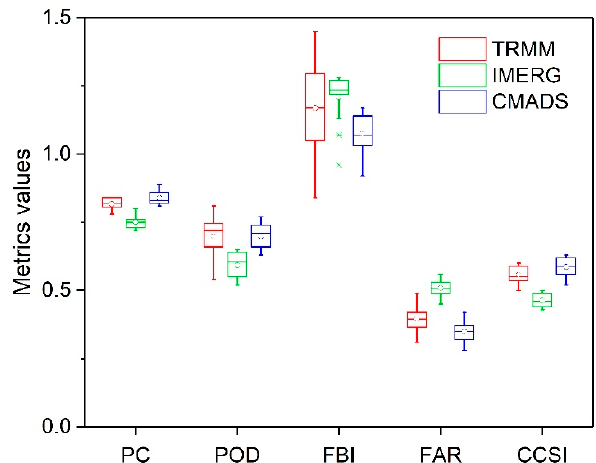
Figure 3. Box plots for the categorical metrics values (Proportion Correct (PC), Probability of Detection (POD), Frequency Bias Index (FBI), False Alarm Ratio (FAR), and Calibration Critical Success Index (CCSI)) of the precipitation detection capacity. The hollow circle represents the mean value, the middle line in the box represents, the median value, and each box ranges from the lower quartile (25th) to the upper quartile (75th).